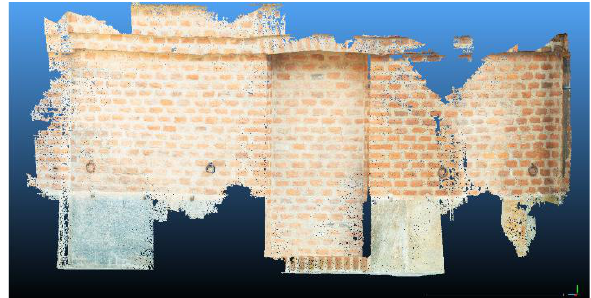
Figure 4: VSfM full spectrum dense point cloud OBJ3